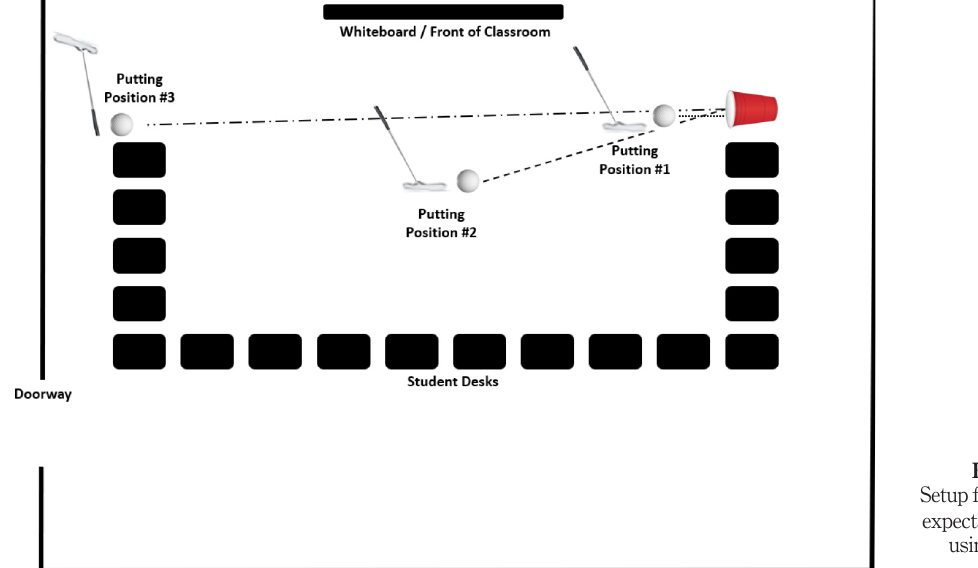
Figure A5. Setup for Vroom ’